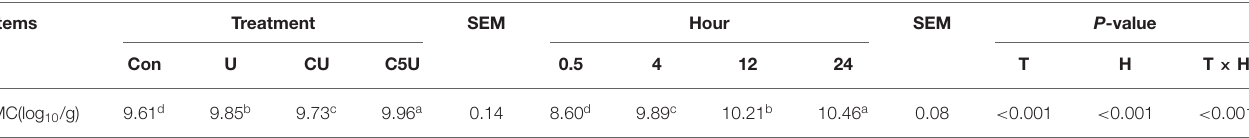
TABLE 2 | Effect of CSL and urea pre-treatment on the particle attached bacterial density in the rumen. Items